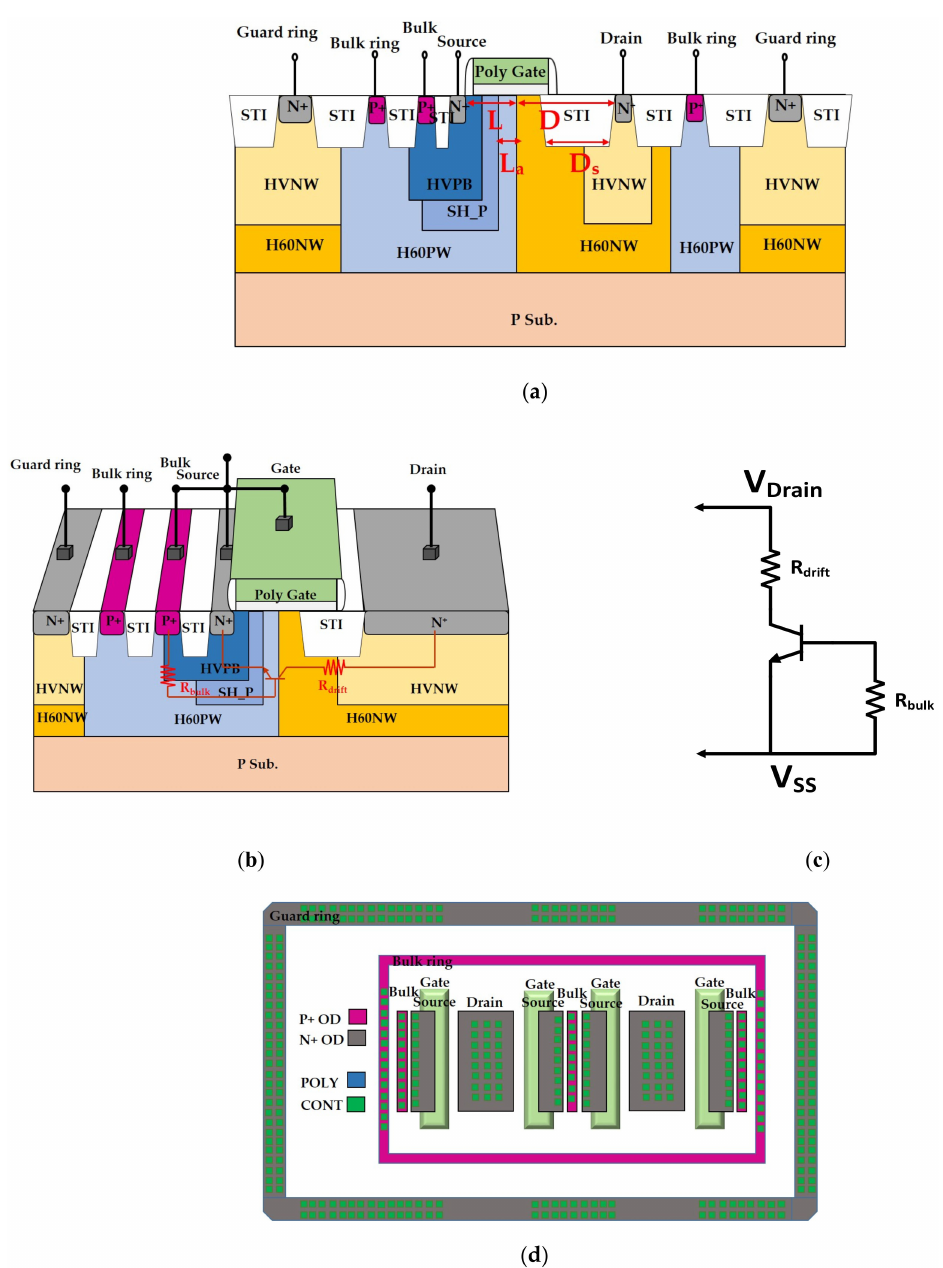
Figure 1. ( a ) Cross-sectional view, ( b ) three-dimensional (3D) structure view, ( c ) parasitic equivalent circuit, and ( d ) layout view of the HV nLDMOS Reference